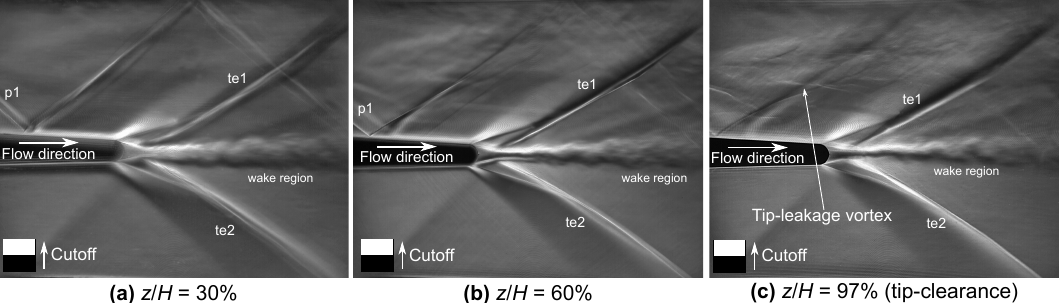
Figure 8. Focusing schlieren images of the flow field in three different planes of focus for the idealized tip-clearance model. The rear third of the blade chord length and trailing edge region is shown for a tip-clearance of τ / H = 2.8% and M 2, is =